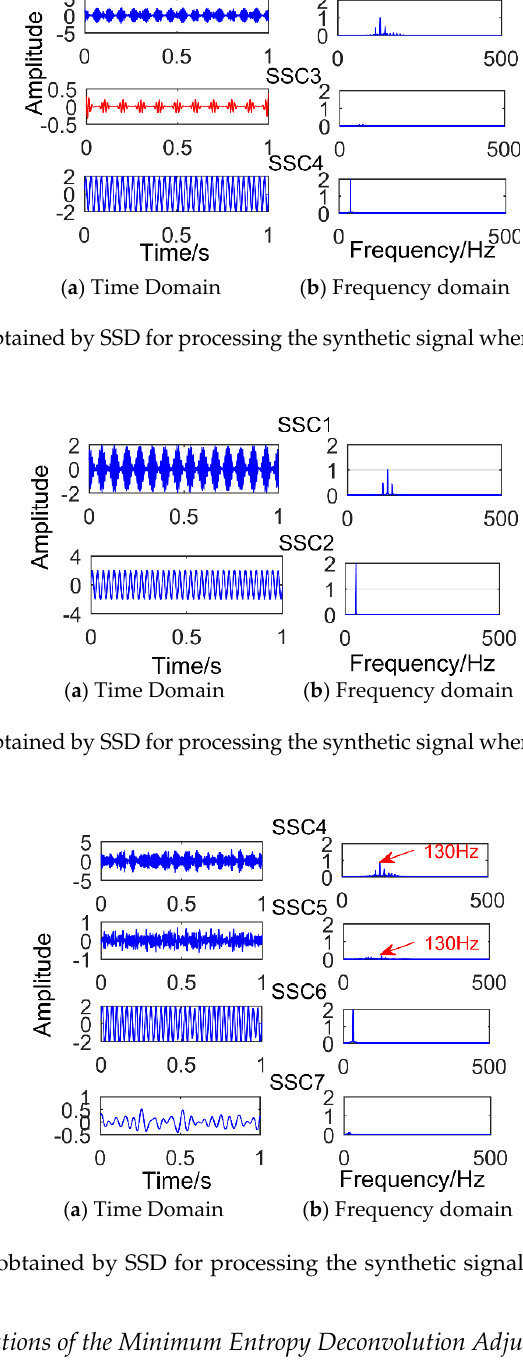
Figure 8. The results obtained by SSD for processing the synthetic signal when adding noise and impact signals.